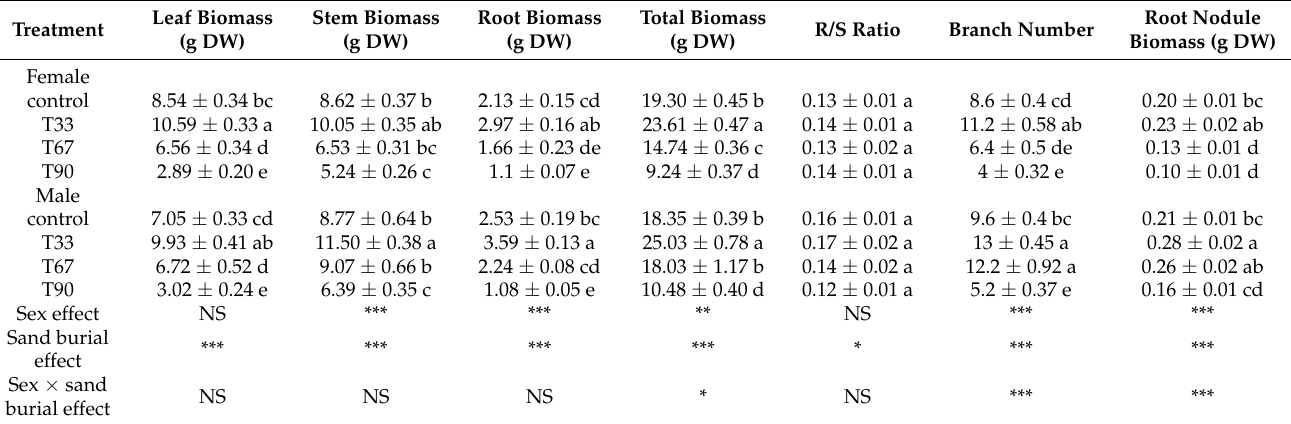
Table 1. Growth parameters of female and male saplings of Hippophae rhamnoides under different sand burial depth